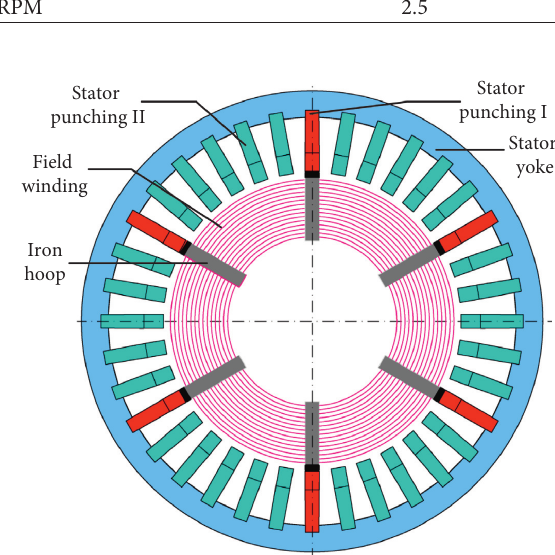
Figure 5: The structure of brushless claw pole EER.